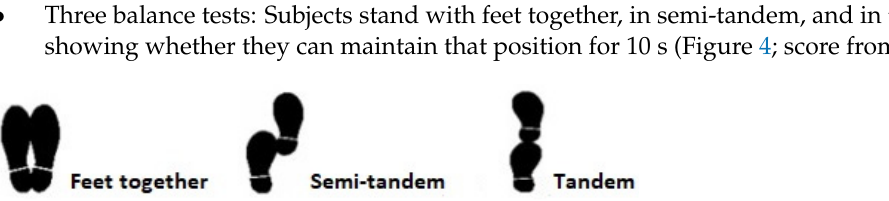
Figure 4. Balance tests (reproduced with permission from Erika Meléndez-Oliva 2020) [43]. A Walking Test at Normal Speed Over 4 Metres: Two attempts are timed and the shortest of them is recorded. The test is scored from 0 to 4 based on the seconds taken (Figure 5).